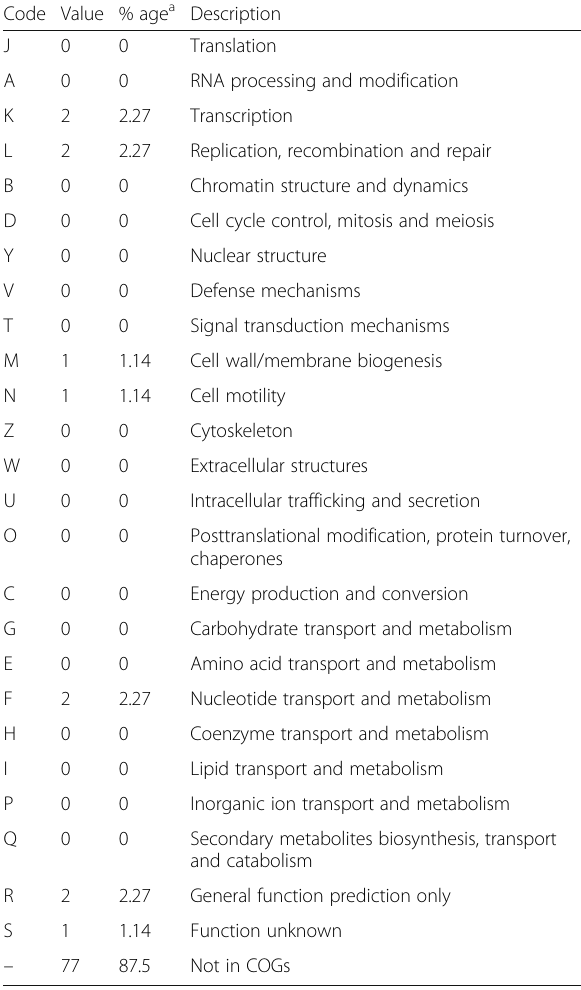
Table 4 Number of genes associated with the 25 general COG functional